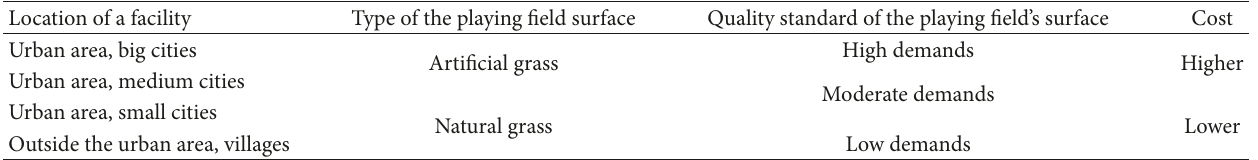
Table 2: General relationship between the three categorical variables and cost (source: own study).